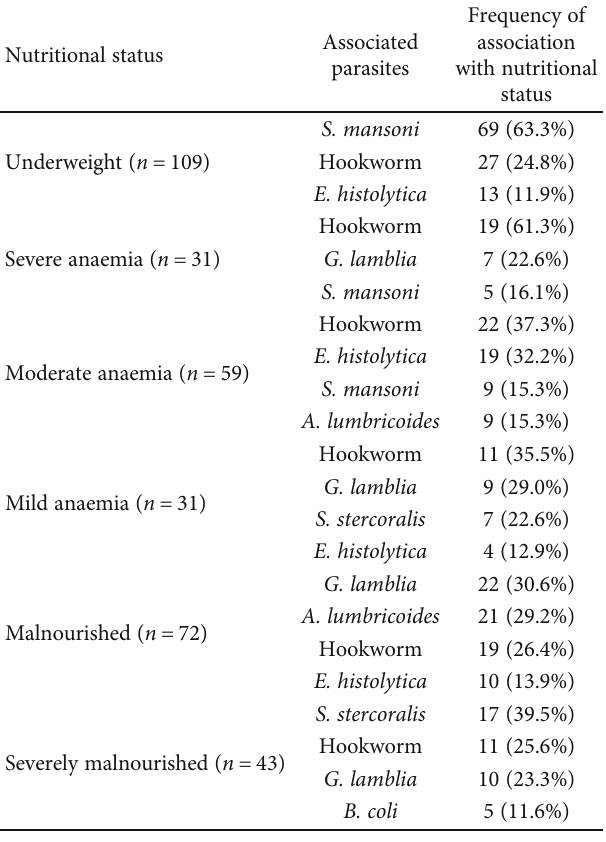
Table 5: Distribution of enteroparasites in underweight, anaemic, and malnourished